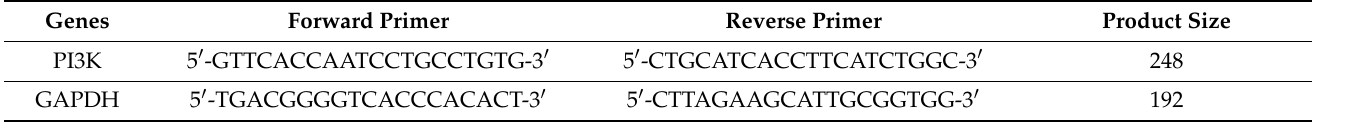
Table 2. PI3K primer sequences used for the polymerase chain reaction